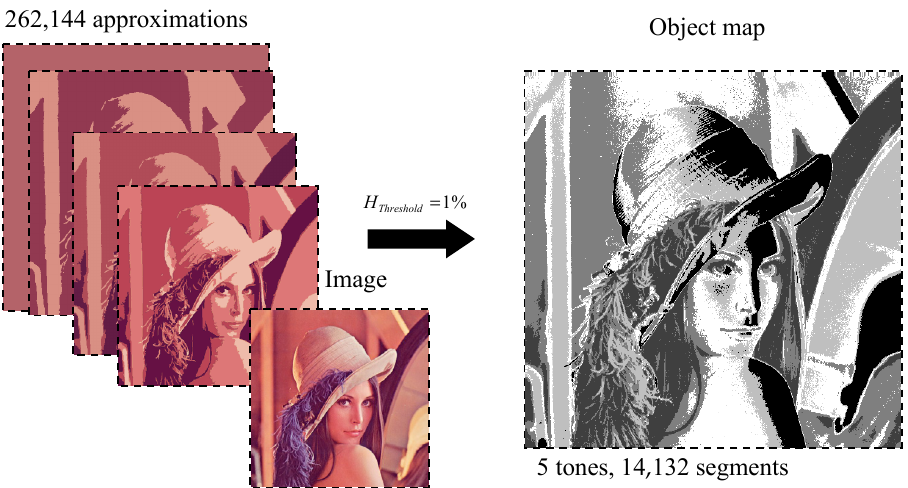
Figure 7. Two-stage detection of objects in a color image.